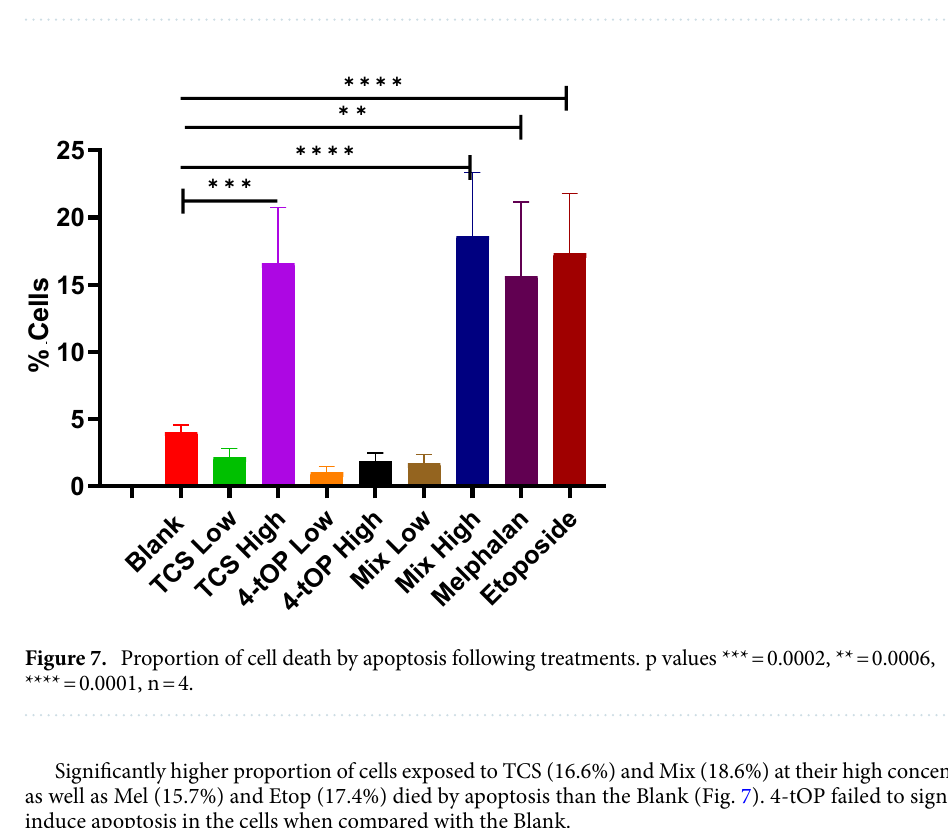
Figure 6. Proportion of live cells after treatments. p values * = 0.023, *** = 0.0009, * = 0.0001, n = 4.